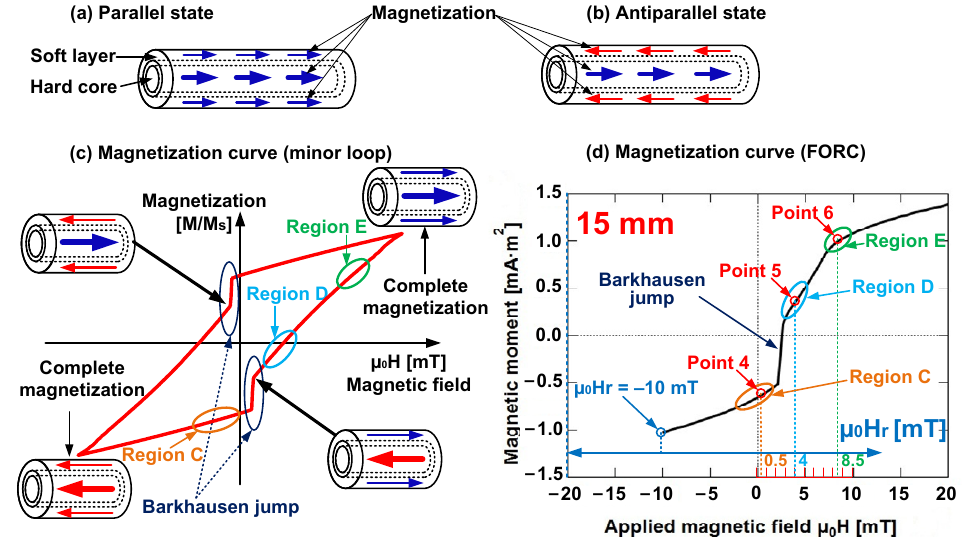
Figure 2. Magnetization states and magnetization curves of Wiegand wire: ( a ) parallel state; ( b ) an- tiparallel state; ( c ) magnetization curve (minor loop); and ( d ) magnetization curve (one first-order reversal curve (FORC)).